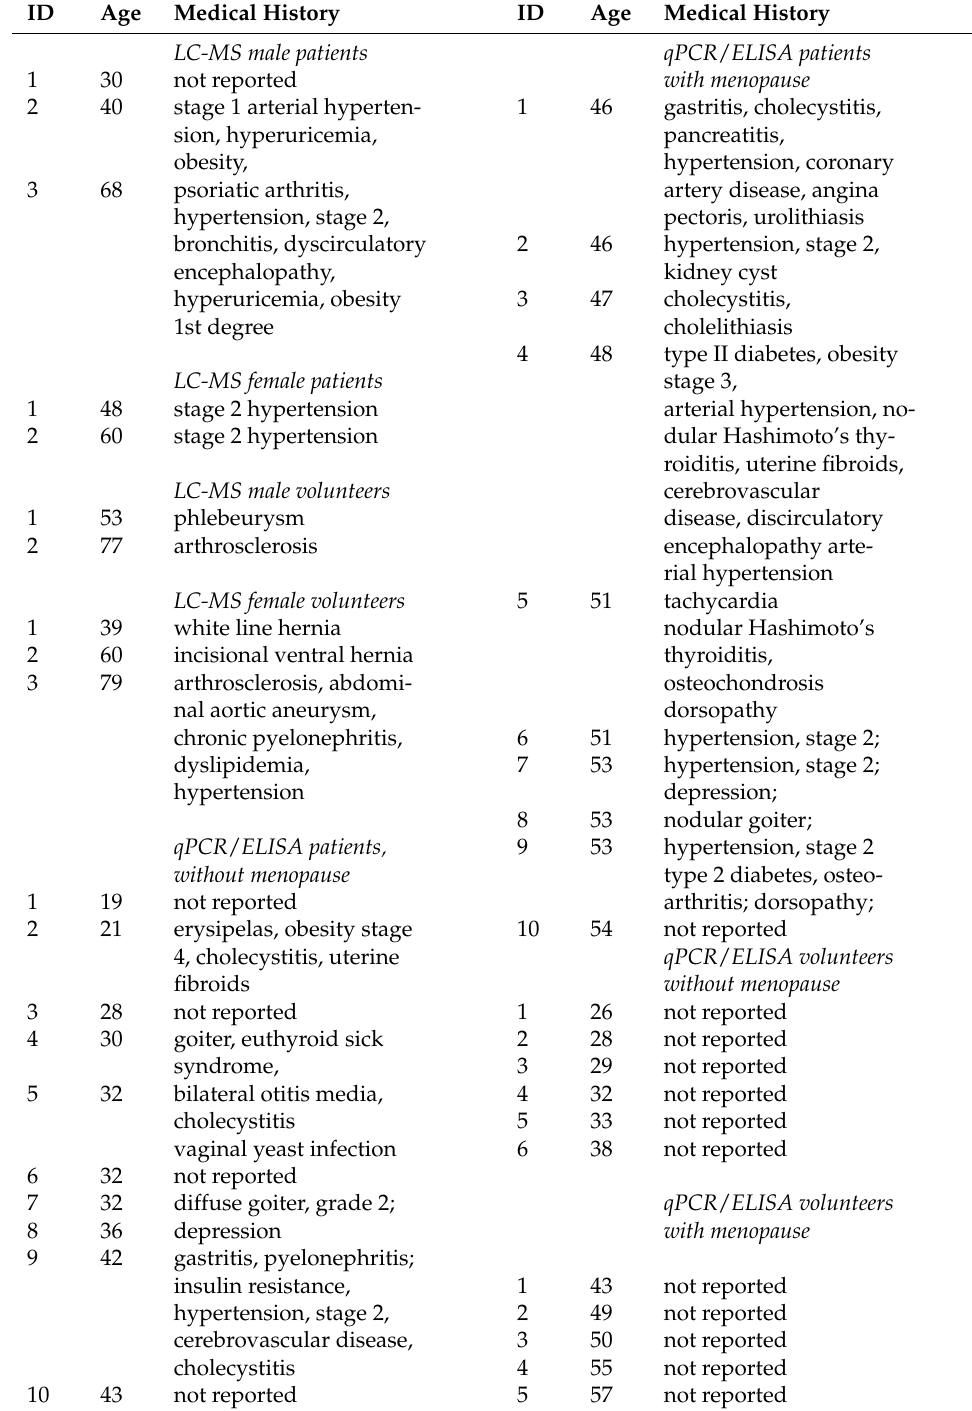
Table 1. Clinical characteristics of psoriasis patients and volunteers that participated in the LC– MS/MS, qPCR, and ELISA